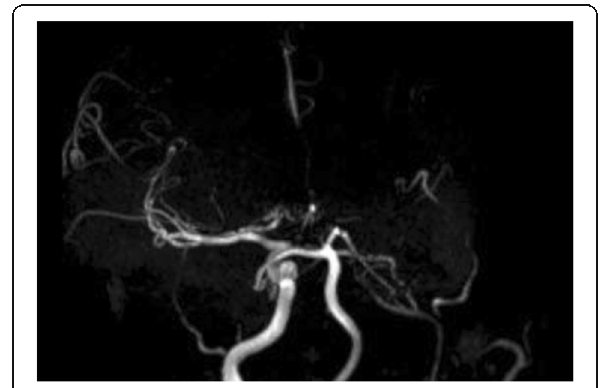
Fig. 18 Three-dimensional reconstruction of MRI angiography (time-of-flight technique) of a 46-year-old Down syndrome patient, illustrating occlusion of the left internal carotid artery (ICA) and stenosis of the supraclinoid segment of the right ICA, as well as subocclusion of the right anterior cerebral artery (ACA). The left ACA and middle cerebral artery are not depicted. There are also multiple thin anomalous collateral vessels around the basal cisterns; these findings are compatible with moyamoya syndrome, which is known to have a high incidence in this